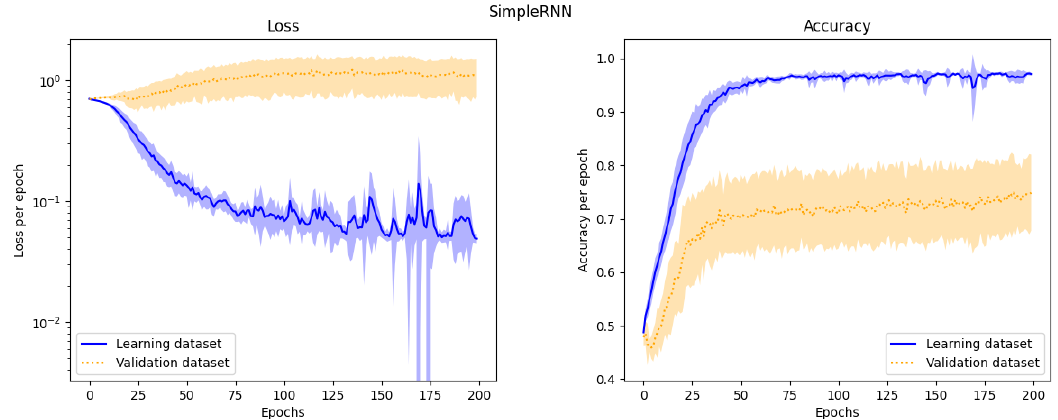
Figure 2. Average loss and accuracy of the models with an RNN over learning epochs.